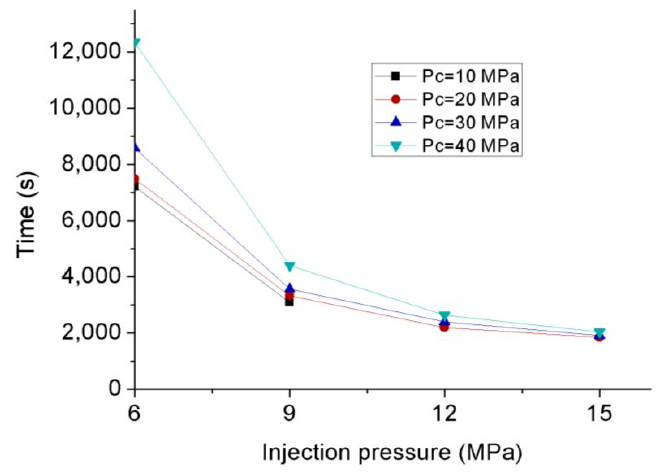
Figure 19. Time for downstream pressure up to 5.5 MPa at different injection pressures and confining pressures.